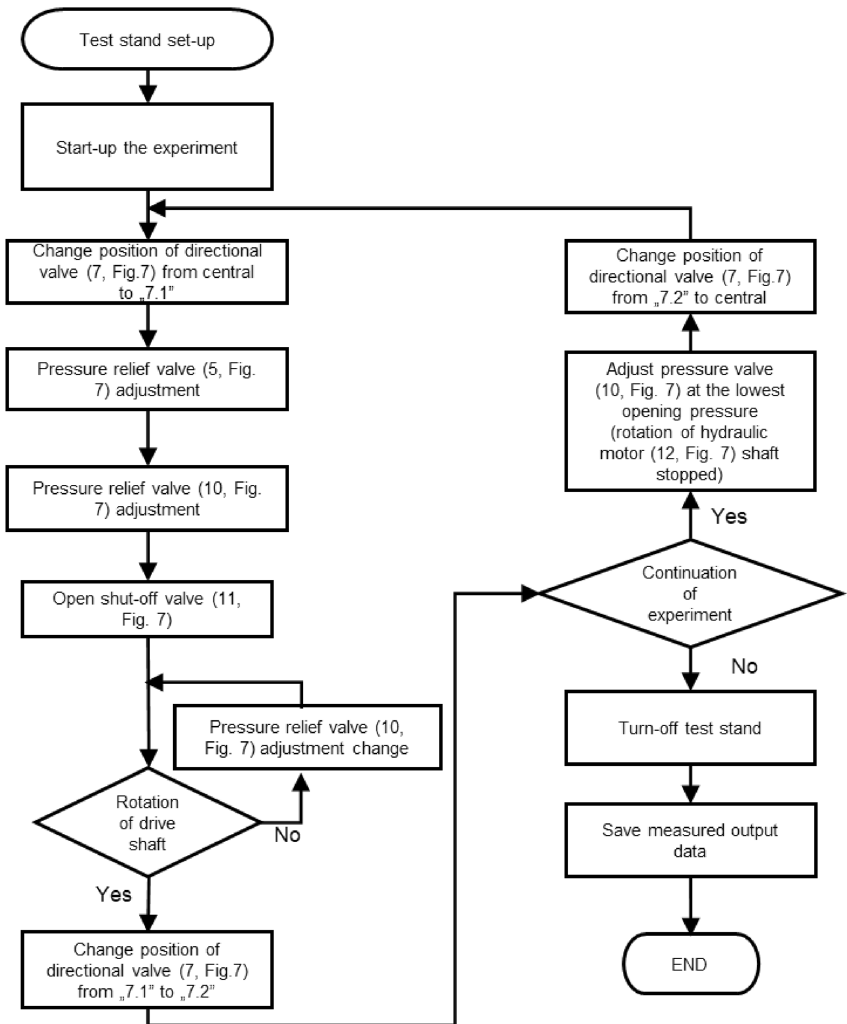
Figure 11. Block diagram of experiment